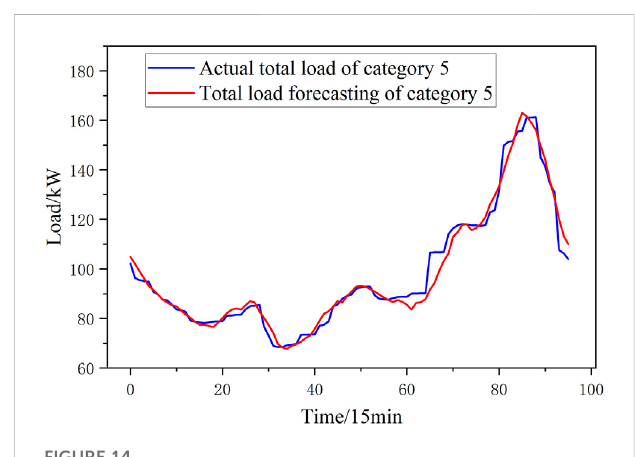
FIGURE 14 Forecasting result of Category 5.